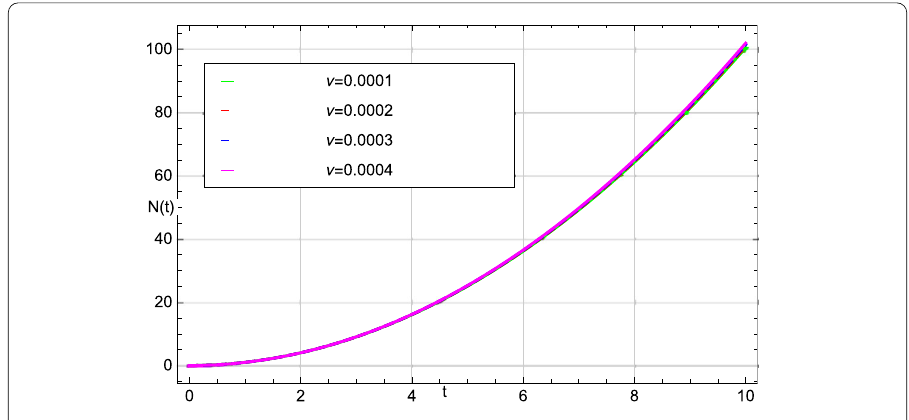
Figure 1 Solution (13) for N ( t ) and t